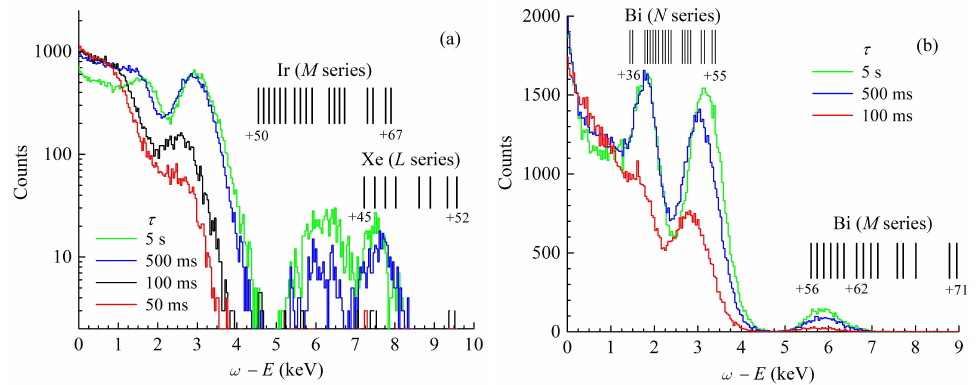
Figure 6. Temporal evolution of the X-ray spectra of the cathode materials and working substance: ( a ) Xe; and ( b ) Bi. Parameters of the electron beam: E = 11.5 keV; I = 20 mA; j ∼ 10 kA/cm 2